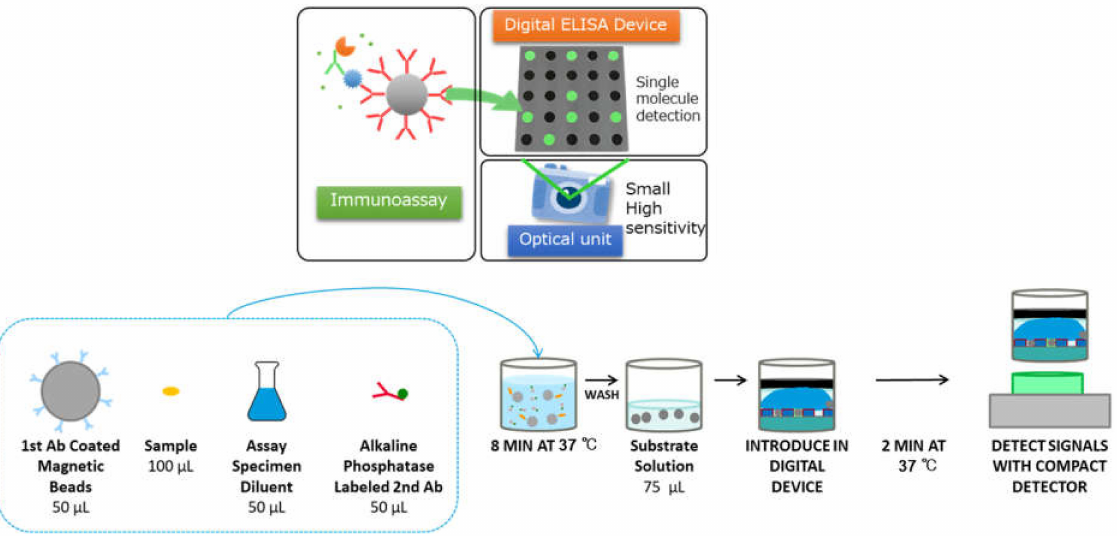
Figure 2. A schematic drawing of SARS-CoV-2 Ag digital immunoassay. Lumipulse SARS-CoV-2 Ag (Fujirebio, Tokyo, Japan) was also used for